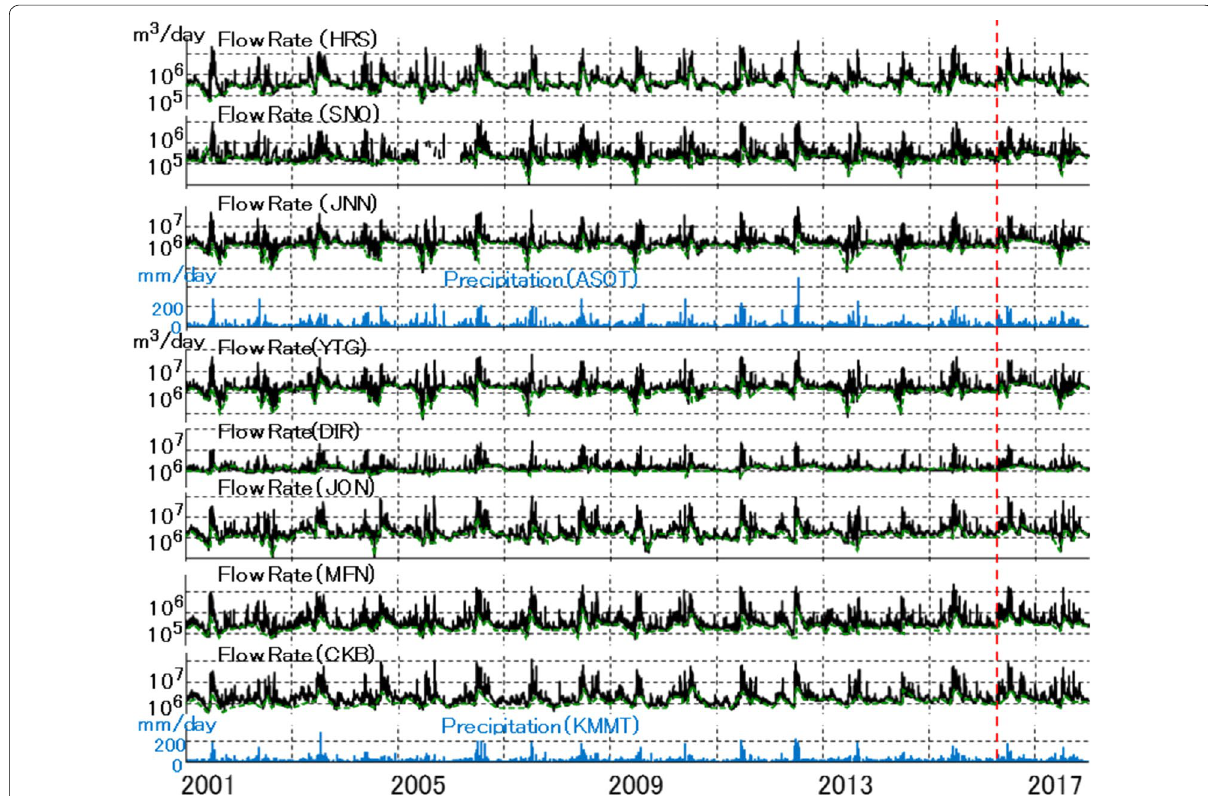
Fig. 4 Daily streamflow rate and precipitation from 2001 to 2017. Vertical red broken line indicates the occurrence of the main shock of the 2016 Kumamoto earthquake. Green broken line shows the minimum envelope of the flow